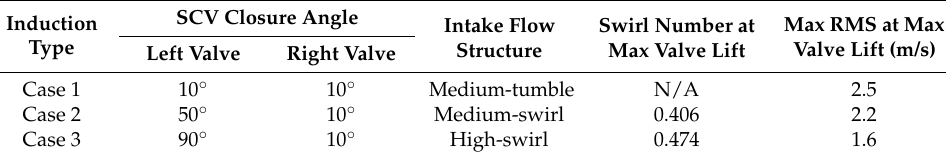
Table 2. Swirl control valve (SCV) adjustments and induction flow